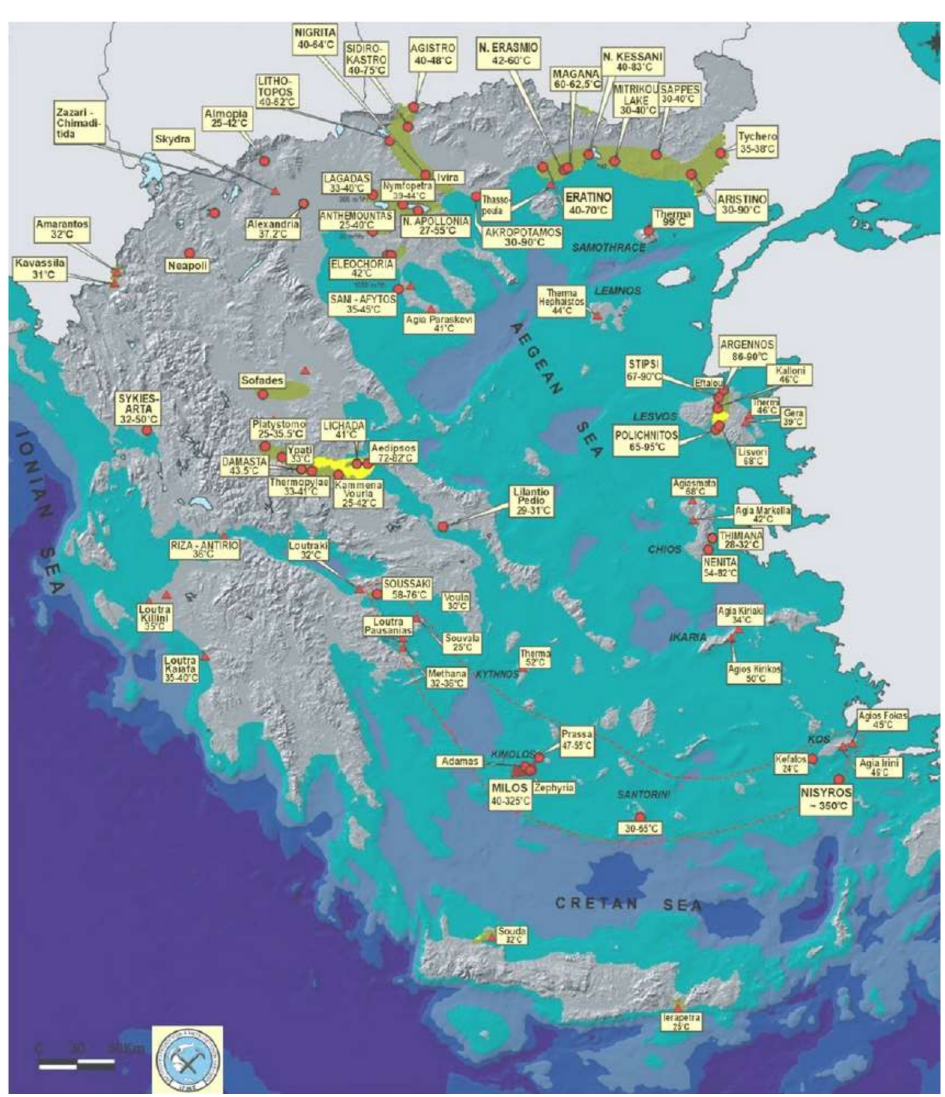
Figure 9. Geothermal fields and areas of geothermal interest in Greece. (This map has been compiled by I.G.M.E.—Division of Geothermal Energy and Thermal Mineral